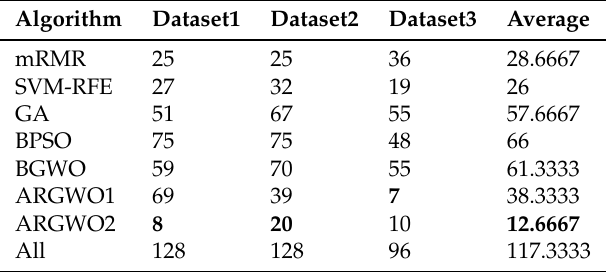
Table 9. Features number comparison of various methods.